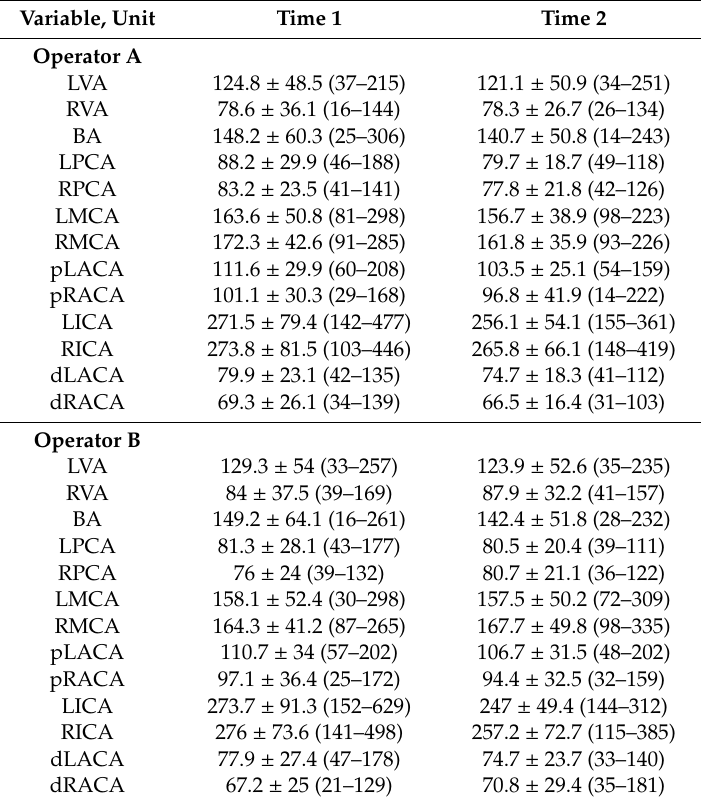
Table 2. Flow measurements by two radiology